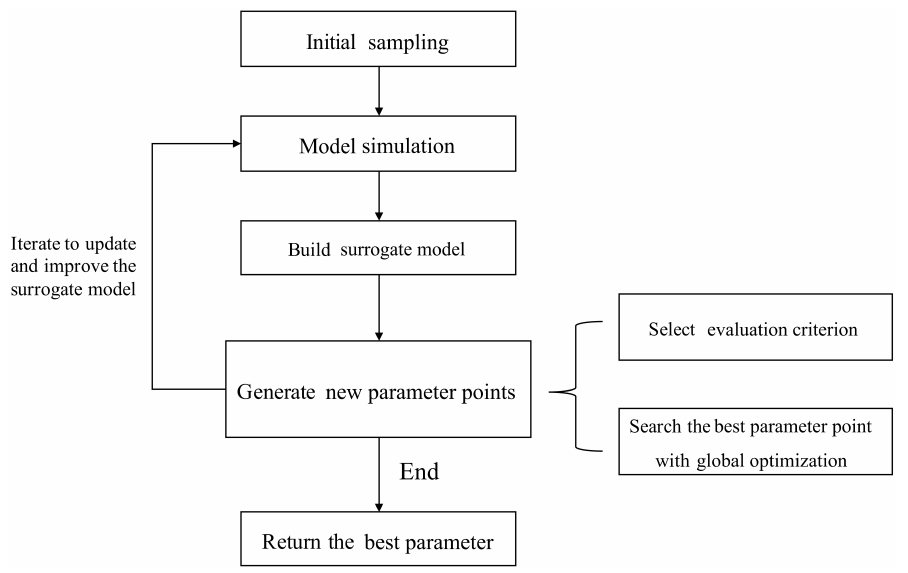
Figure 3. A flowchart of the surrogate-based